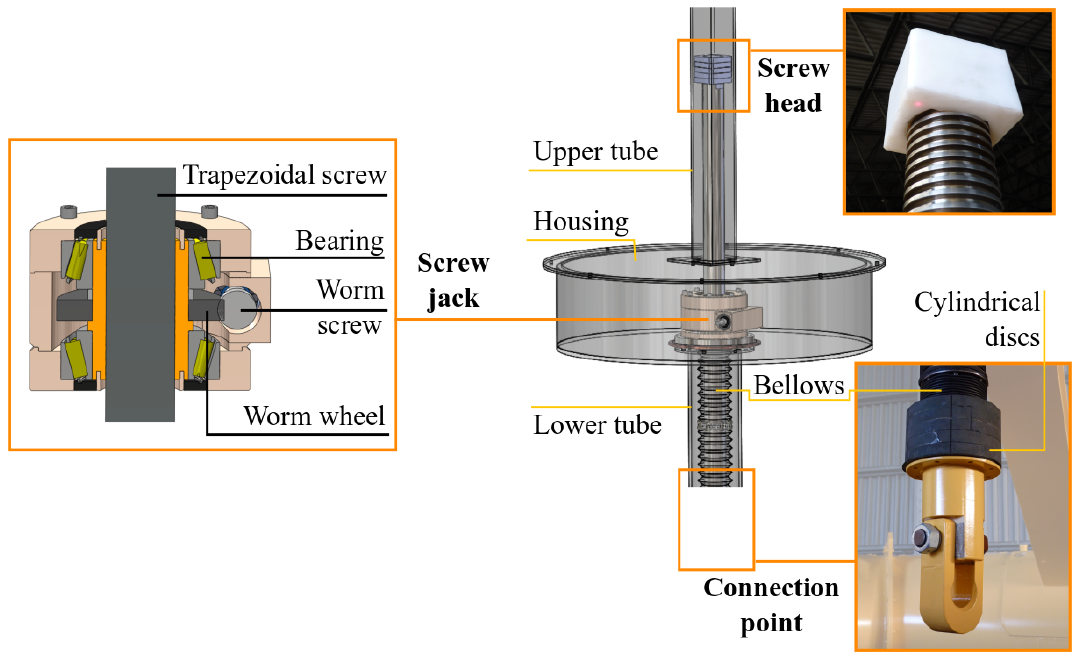
Figure 3. Drawing of the mechanical device. From the top right, the screw head slides into a tube with a square cross-section; the screw jack is protected inside a steel housing that will contain the control and measurement systems, as well; the lower part of the screw is fitted with bellows to avoid contact with water and slides into a round cross-section tube; the lowest part of the screw terminates with a socket that is connected to the line down to generator.